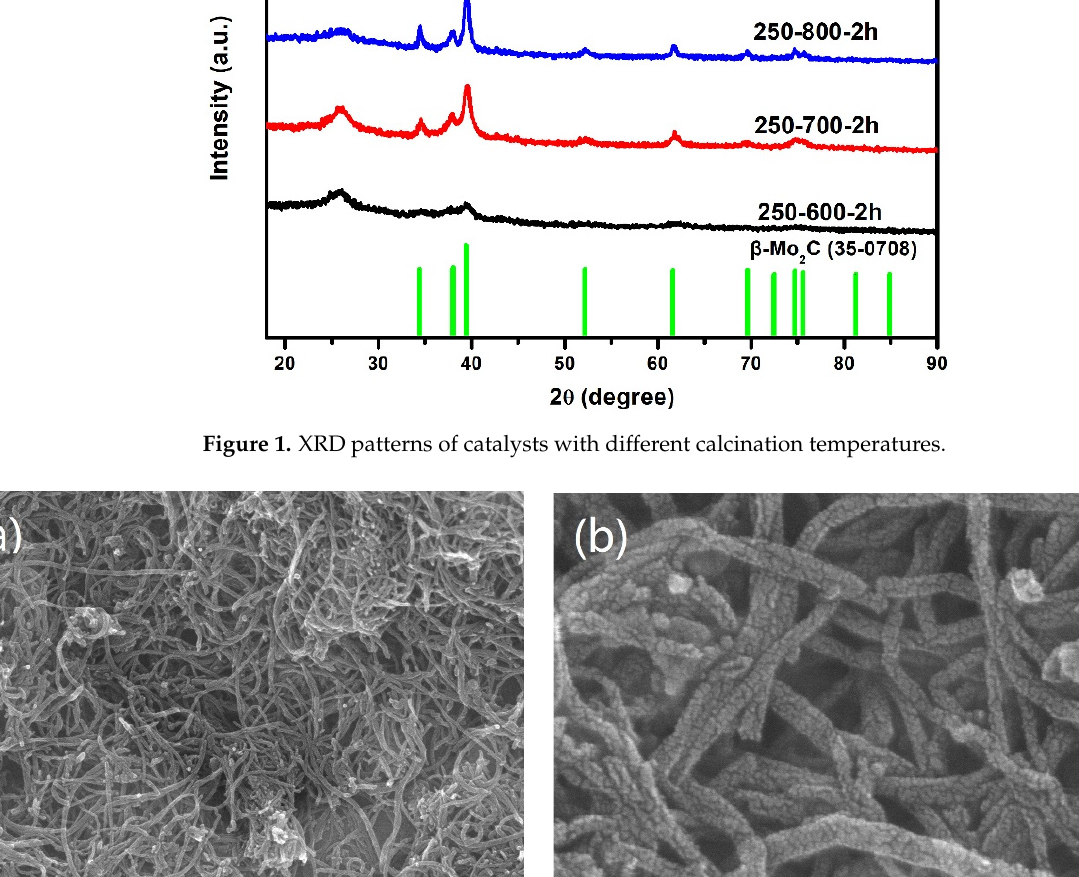
Figure 1. XRD patterns of catalysts with different calcination temperatures.